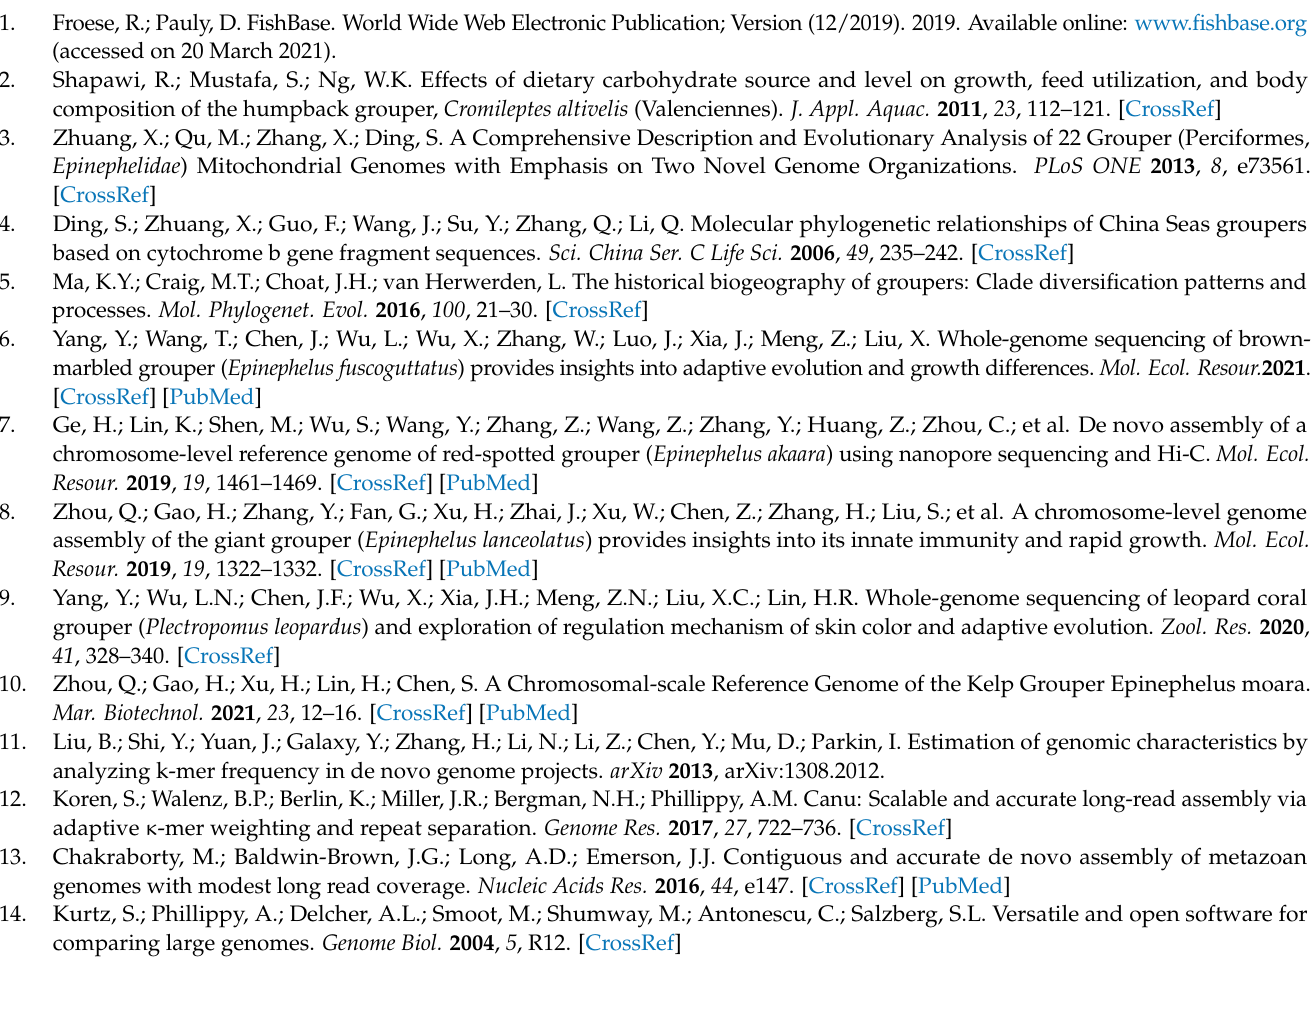
Table S1: The statistics of repeat information in humpback grouper genome, Table S2: Gene pre- diction of humpback grouper, Table S3: Construction statistics of predicted genes in humpback grouper